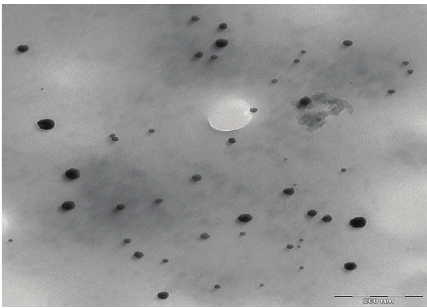
Figure 2: TEM image of AuNPs reduced with 100mM of MSG.